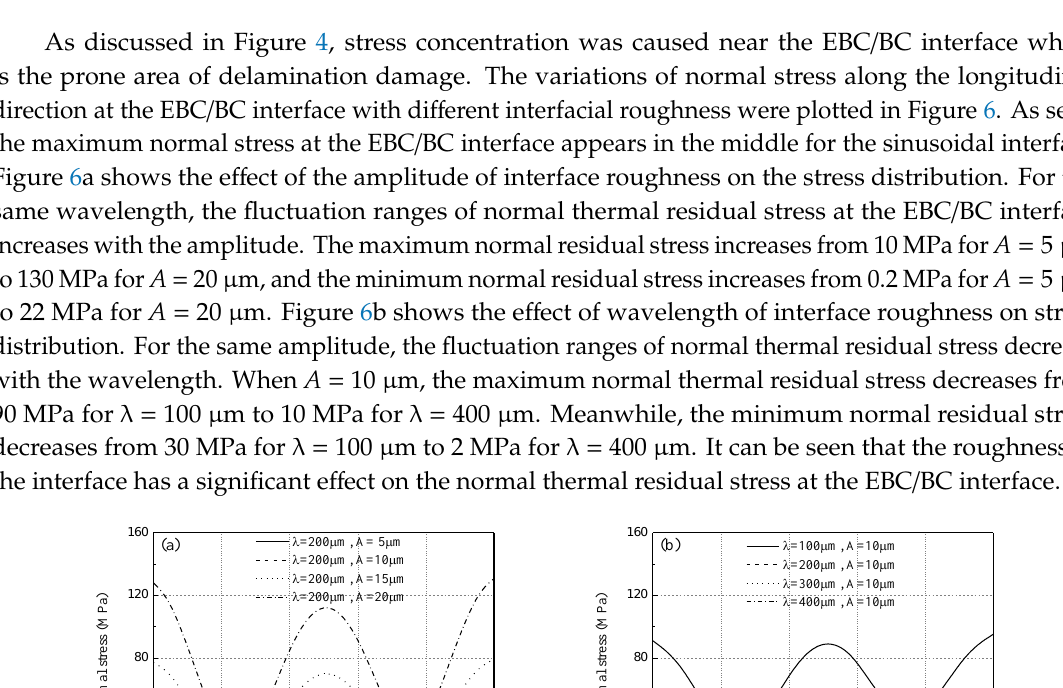
Figure 7. Variations of tangential thermal residual stress along the EBC/BC interface of CMCs coatings with different ( a ) amplitude; ( b ) wavelength. 3.2. The Effect of Rough Interface On Thermal Stress under Service Conditions The CMCs components are usually designed to service under a large thermal gradient. Here, the thermal stress distribution of the coated system under a thermal gradient is simulated. Under the given simulation conditions, the variation of temperature with depth in the coated system was obtained. It can be seen from Figure 8 that the temperature at the top surface of the TBC layer reaches above 1500 °C, and the temperature at the bottom of the TBC layer drops to less than 1200 °C. The temperature at EBC/BC interface drops to less than 1100 °C and the temperature at the top surface of CMCs decreases slightly. It can be seen that the TBC layer works well as a thermal barrier. Figure 8a,b also compare the effects of roughness amplitude and wavelength on temperature variation. It